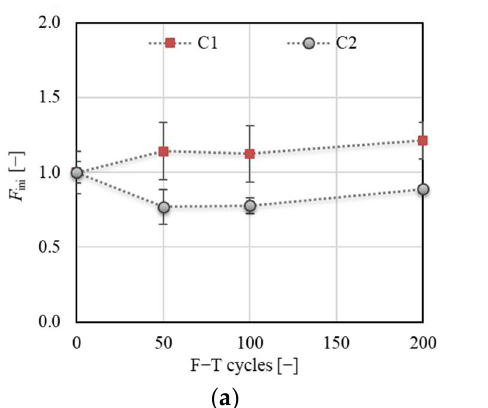
ini ; ( b ) load level F max